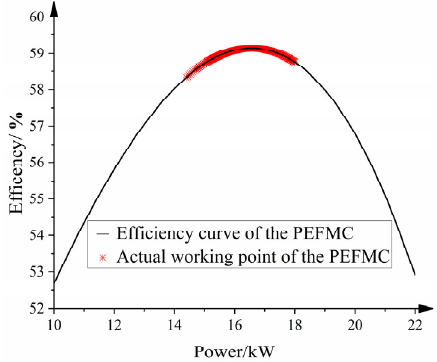
Figure 18. The actual working point of the hydrogen fuel cell.